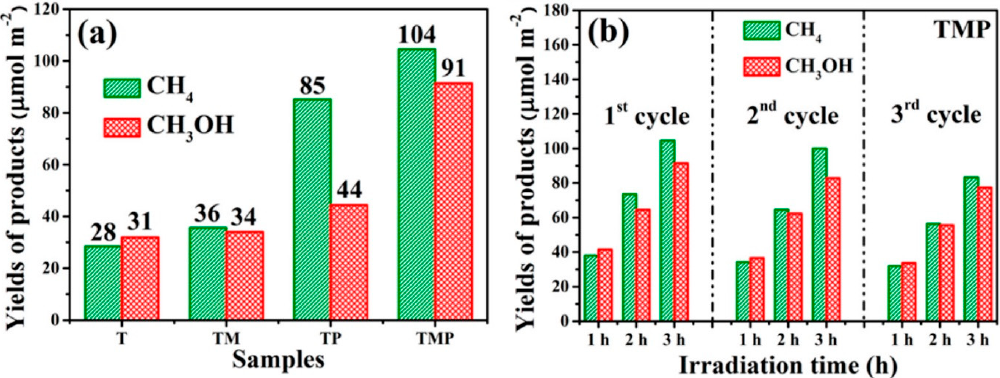
Figure 14. ( a ) Photocatalytic degradation of CO 2 activity of TiO 2 (T), TiO 2 –Pt (TP), TiO 2 –MnO x (TM), and TiO 2 –MnO x –Pt (TMP) under UV–Vis for 3 h. ( b ) Photocatalytic cycling test of TMP. Reprinted with permission from